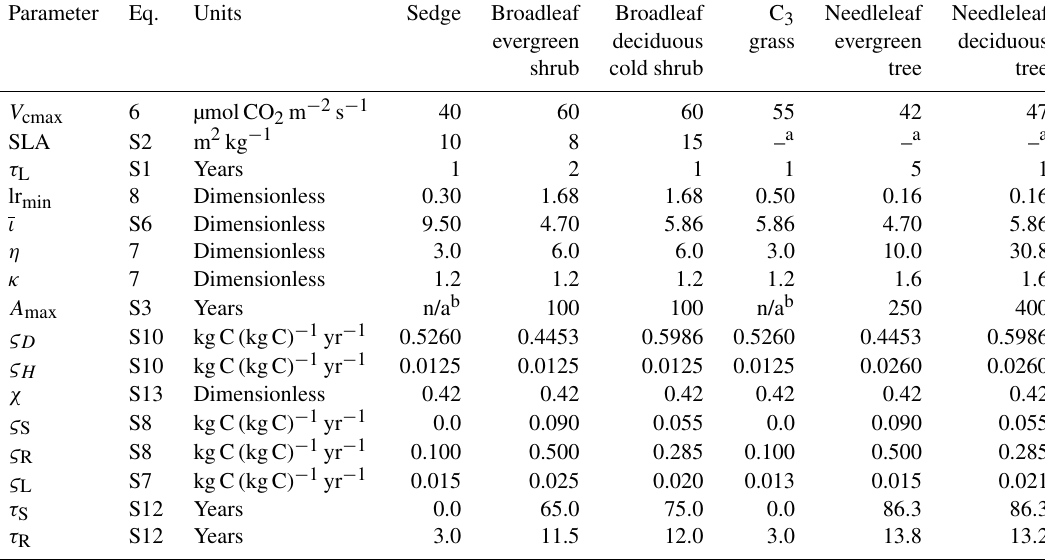
Table 2. CLASSIC’s biogeochemical parameter values for the PFTs used in this study, including the new PFTs (sedge, broadleaf evergreen shrub, and broadleaf deciduous cold shrub). Equation numbers refer to those in this text or the Supplement. The parameters are V cmax : maximum carboxylation rate by the Rubisco enzyme; SLA: specific leaf area; τ L : leaf life span; lr min : minimum root-to-shoot ratio affecting the allocation of C; ι : parameter determining the root profile and rooting depths; η and κ : parameters determining the minimum stem and root biomass required to support the green leaf biomass; A max : maximum vegetation age affecting the intrinsic mortality rate; ς D : litter base respiration rate at 15 ◦ C; ς H : soil C base respiration rate at 15 ◦ C; χ : humification factor determining fraction of C transferred from the litter to the soil C pool; ς S : stem base respiration rate at 15 ◦ C; ς R : root base respiration rate at 15 ◦ C; ς L : leaf maintenance respiration coefficient;